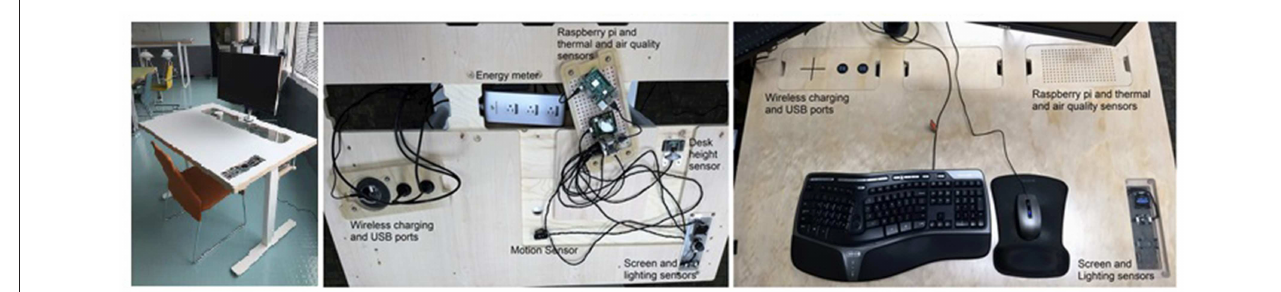
FIGURE 2 | Current prototype of the desk showing different